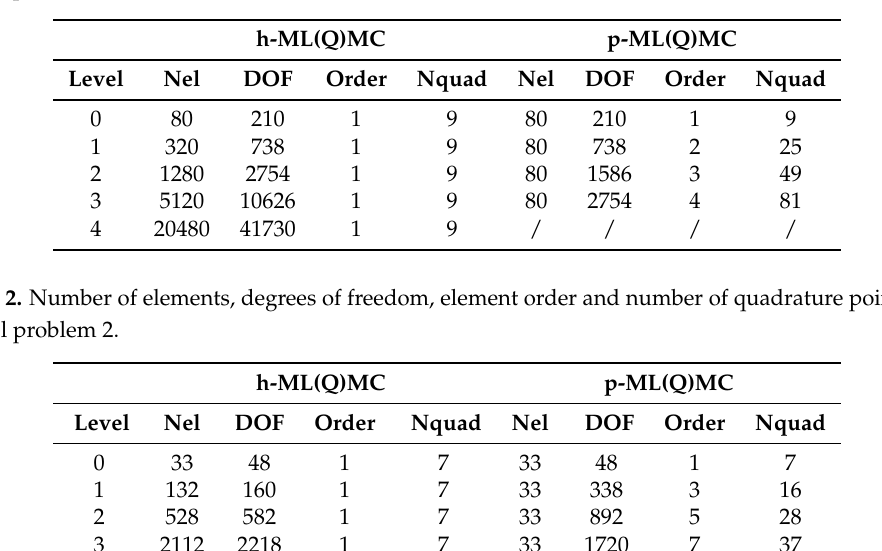
Table 1. Number of elements, degrees of freedom, element order and number of quadrature points for model problem 1.